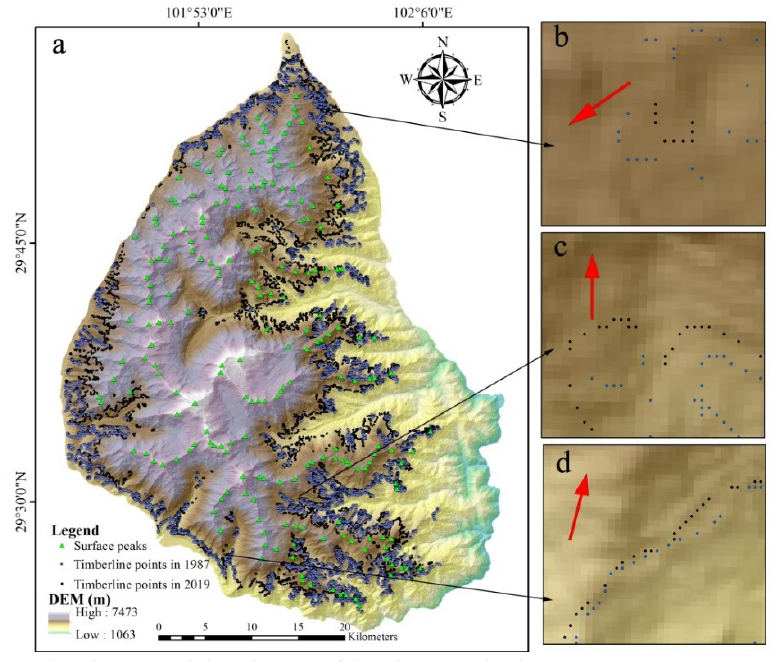
Figure 5. Spatial and temporal distribution of the alpine timberline on Gongga Mountain from 1987–2019: ( a ) spatial distribution of alpine timberline points in 1987 and 2019; ( b ) timberline presents downtrend; ( c ) timberline presents uptrend; ( d ) timberline presents unobvious trend. Note: the red arrows represent the direction of the top of the mountain.